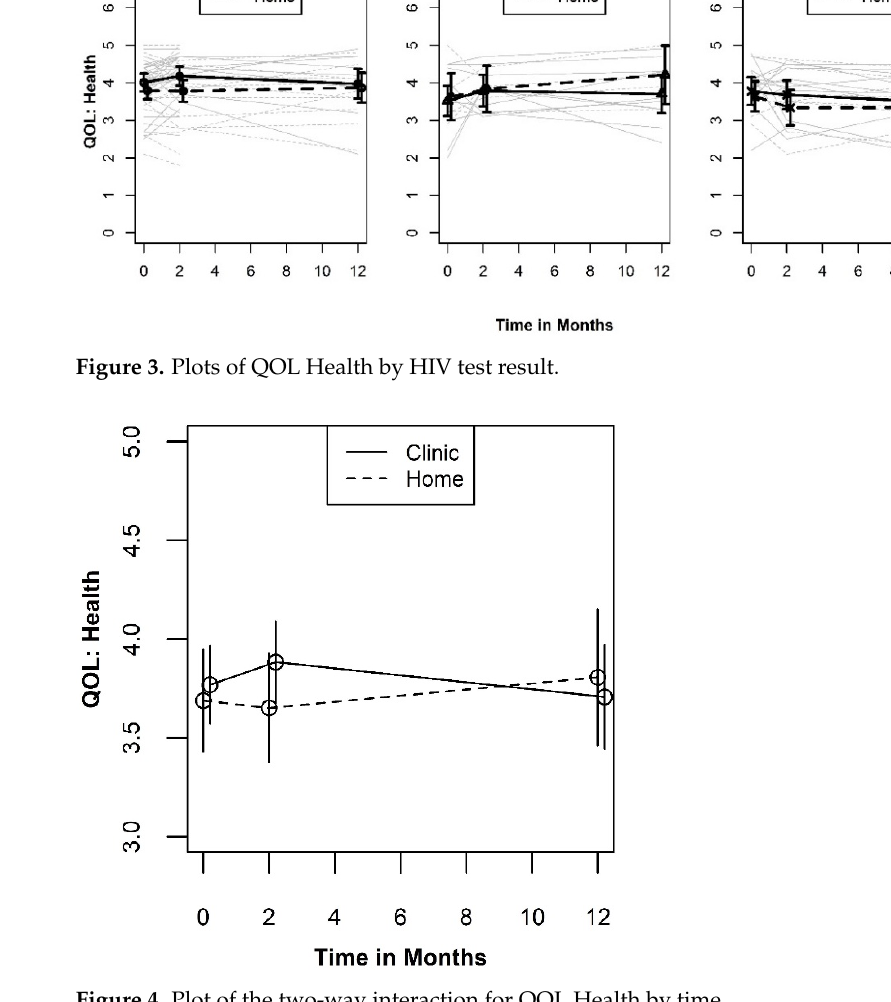
Figure 4. Plot of the two-way interaction for QOL Health by time .